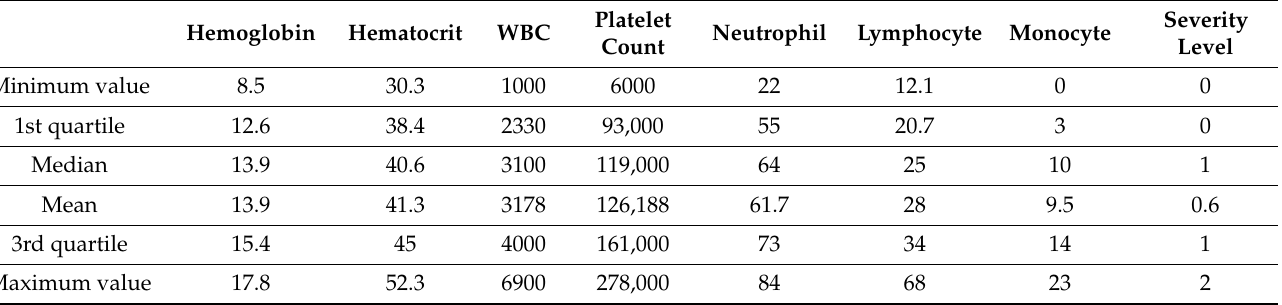
Table 1. Dengue patients’ data